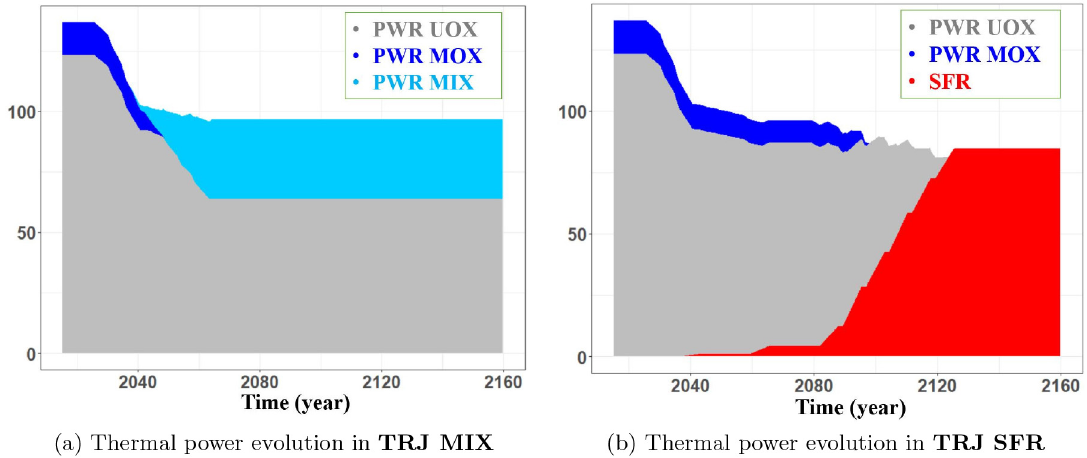
Fig. 3. Thermal power evolution in two prior trajectories TRJ MIX and TRJ SFR (in